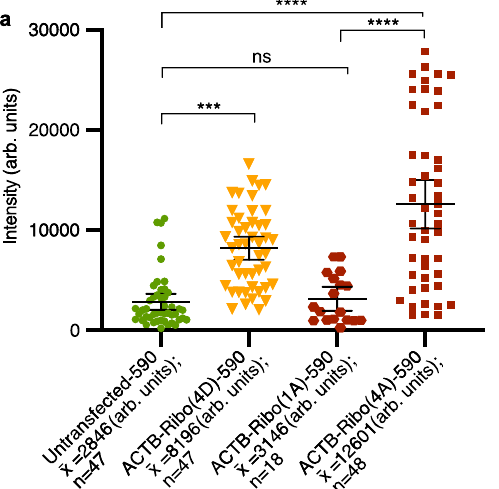
Fig.3|ComparisonofimagingRiboglow-taggedRNAby fl uorescenceintensity vs. lifetime. Quantitative comparison of Riboglow-tagged RNA visualization via background-subtracted fl uorescence intensity ( a ) and fl uorescence lifetime ima- gingmicroscopy(FLIM)( b ),asoutlinedinFig.2a.Foreachcondition,thesamecells were analyzed in ( a ) and ( b ). A whole-cell was de fi ned as an ROI and fl uorescence